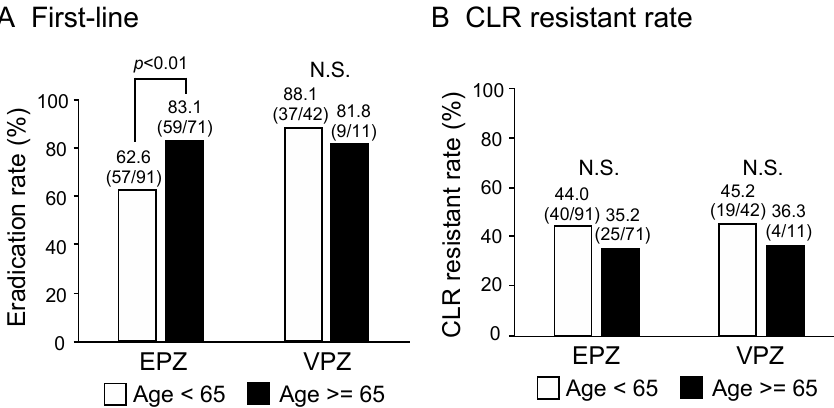
Figure 3. The effect of patient age on the success rate (PP) of first-line H. pylori eradication. ( A ) For EPZ-based triple therapy, the success rate of first-line H. pylori eradication was significantly higher in patients aged over 65 years than in those under 65 years of age. For VPZ-based triple therapy, there was no significant difference between patients under and over 65 years of age in the success rate of first-line H. pylori eradication therapy. ( B ) There was no significant difference in the rate of CLR resistance between patients under and over 65 years of age who received EPZ-based and VPZ-based first-line triple therapy.